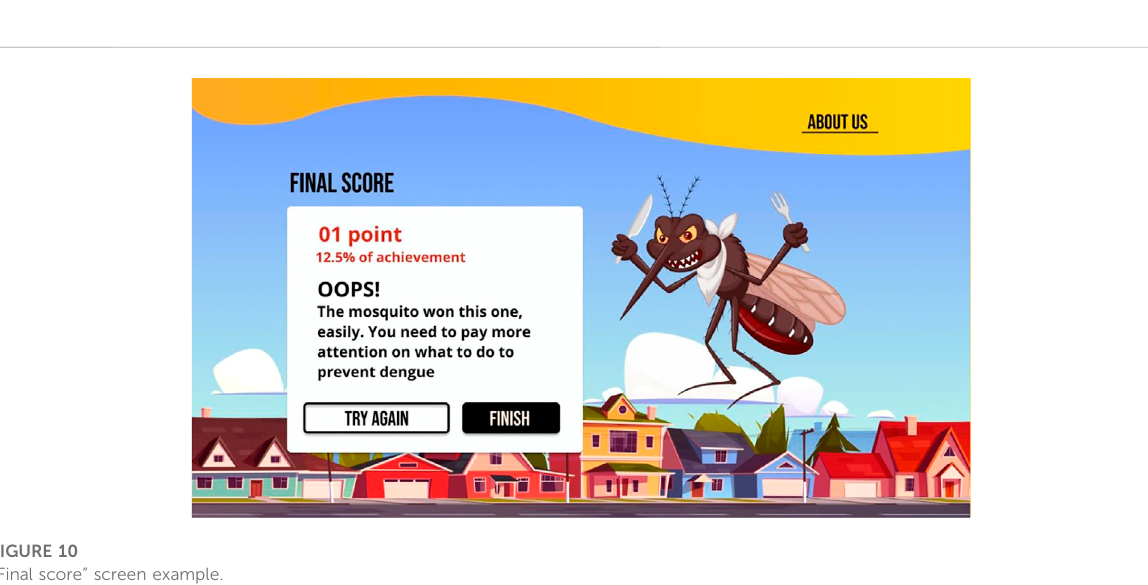
FIGURE 10 “ Final score ” screen